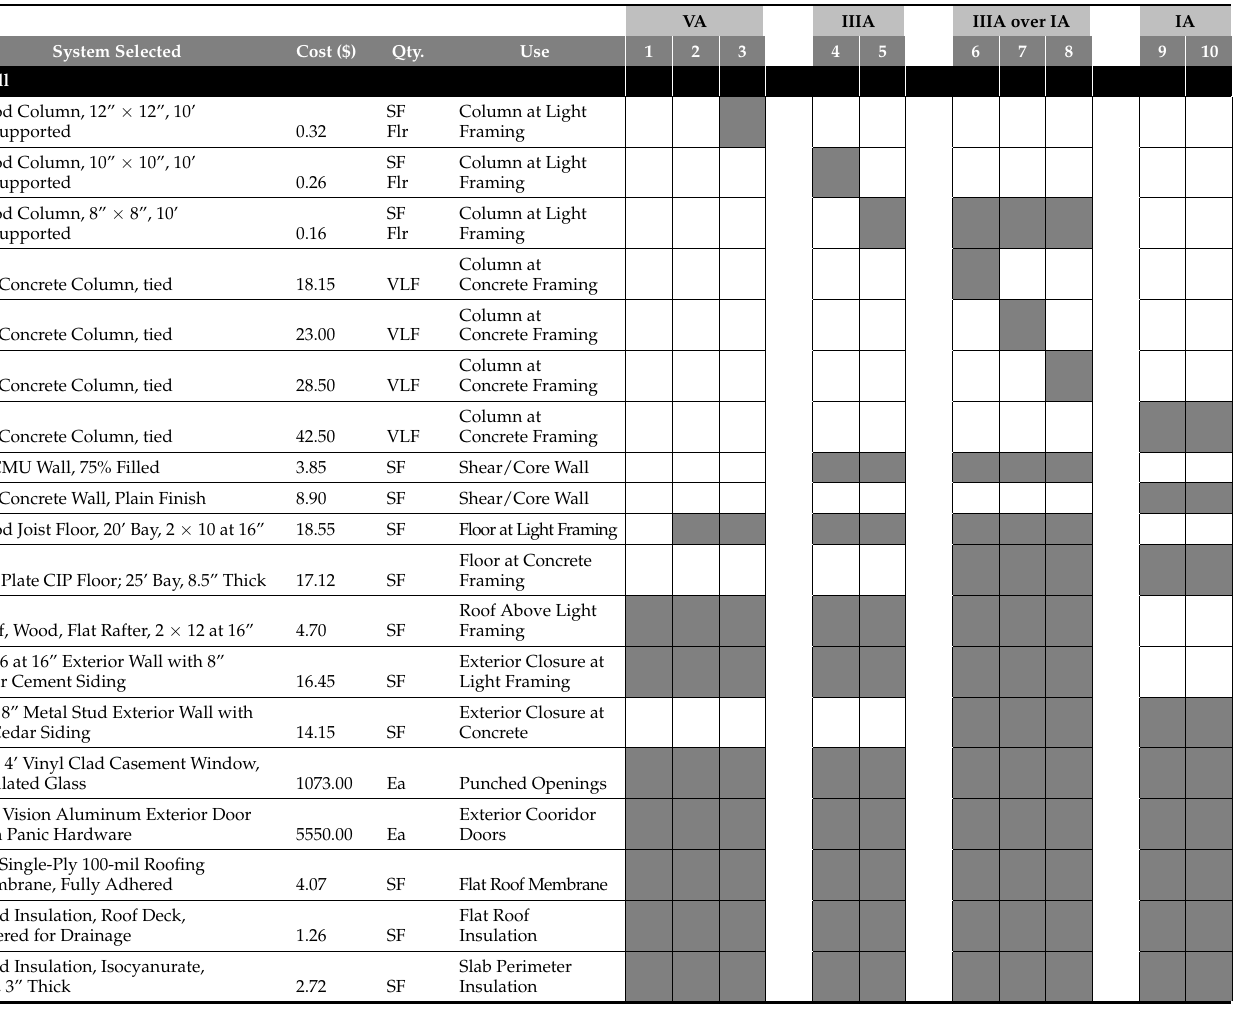
Table 2. Structure and Shell Systems, Costs, and Designated